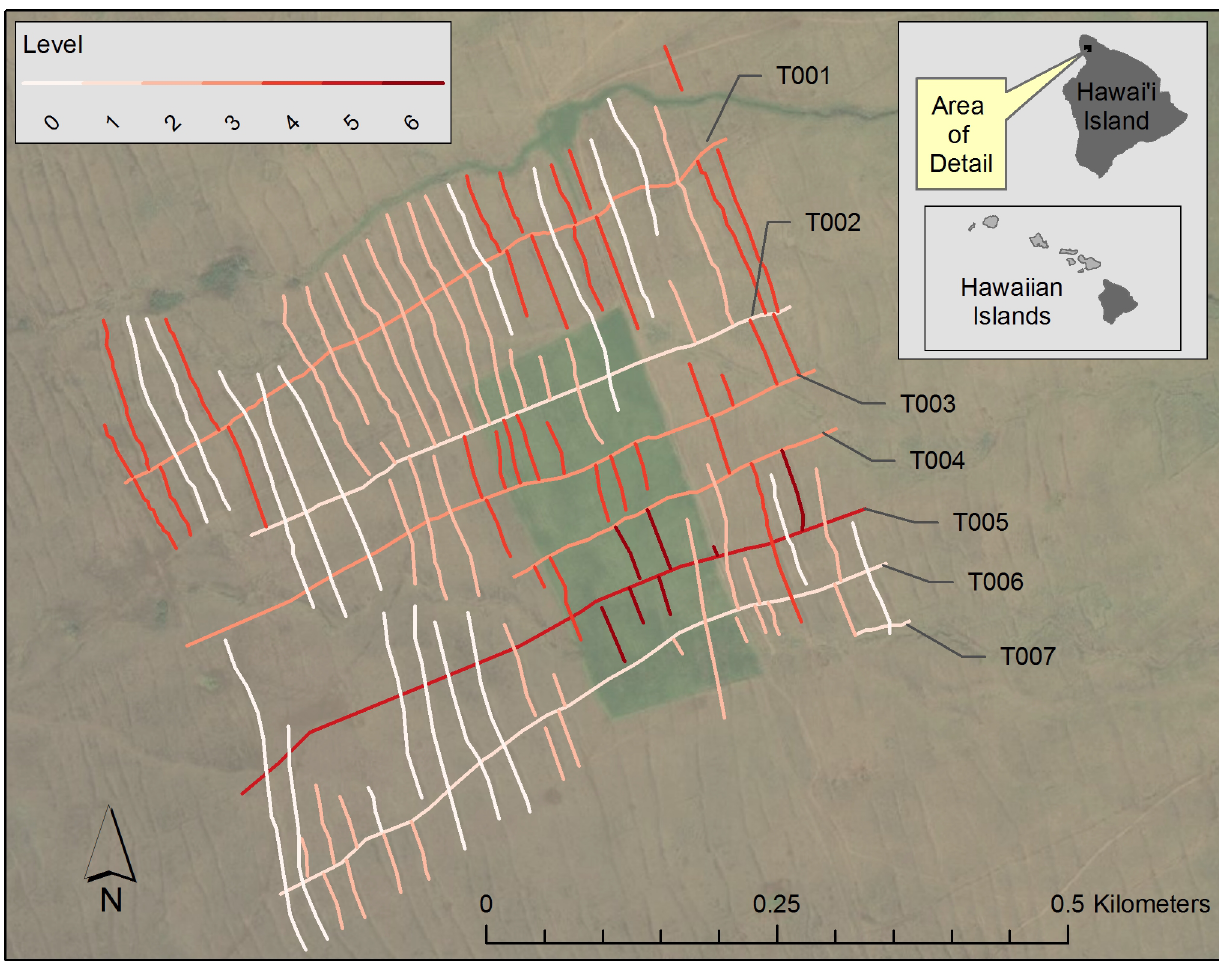
Figure 10. Level assignments in the Kahua 1 and Pa¯hinahina detailed study area. The trails are labeled. See File S2 for a map of features that includes agricultural wall labels. See Table S10 in File S3 for the model of relative chronological relationships used to create the map. A picture of the directed graph of the relative chronological relationships in the Kahua 1 and Pa¯hinahina detailed study area is included as Figure S3.